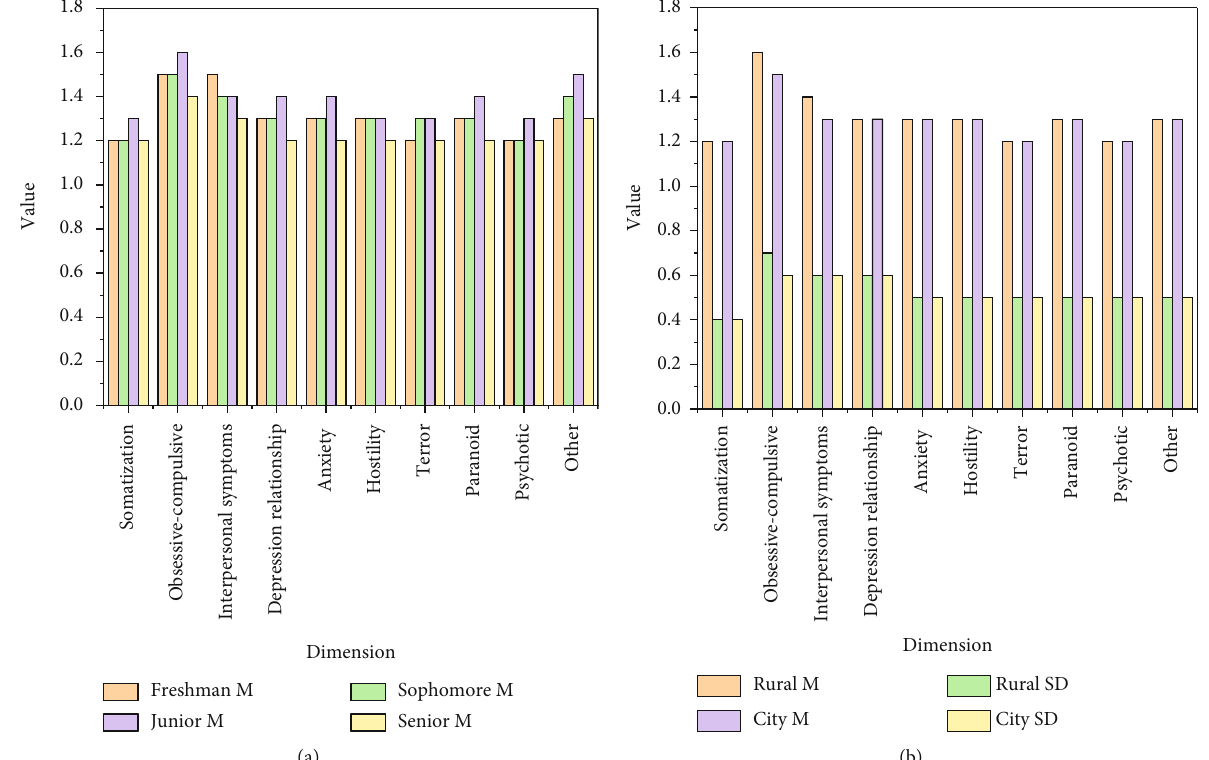
Figure 5: Overall survey results of the self-evaluation form and gender di ff erences ((a) general situation; (b) gender di ff erences).